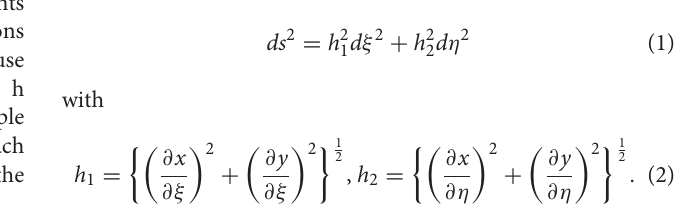
increment satisfies the